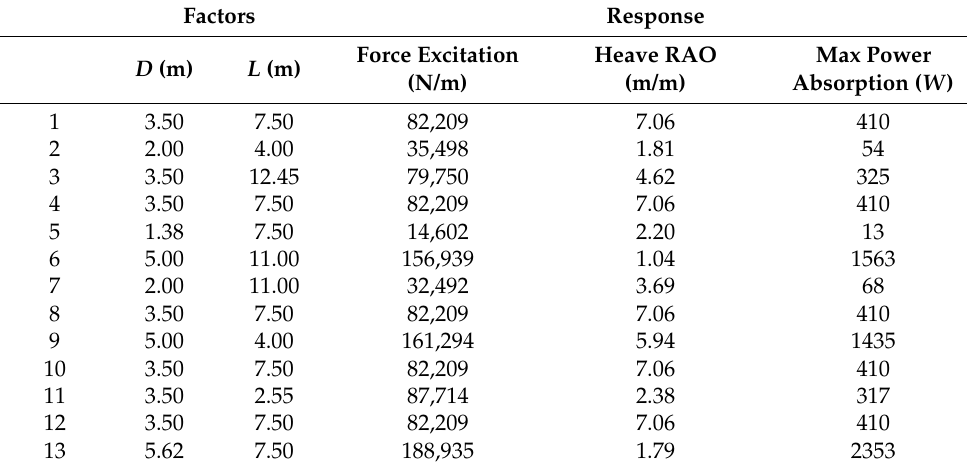
Table 3. Simulations Designed for Back